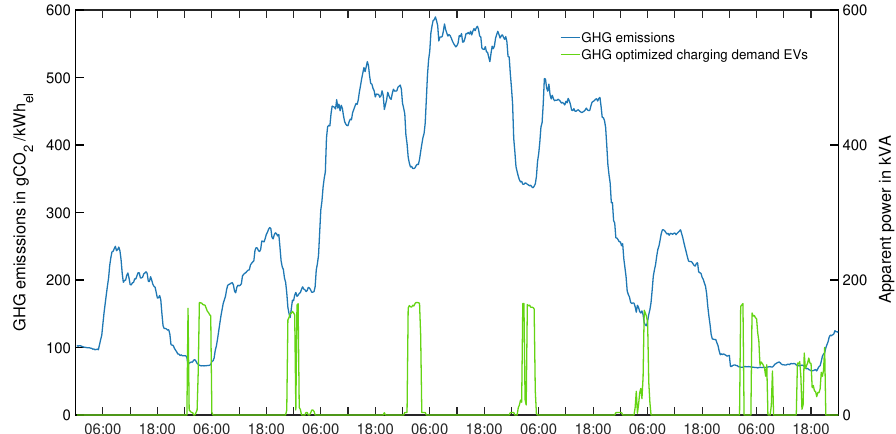
Figure 12. GHG-optimized charging demand of EVs for one week in the